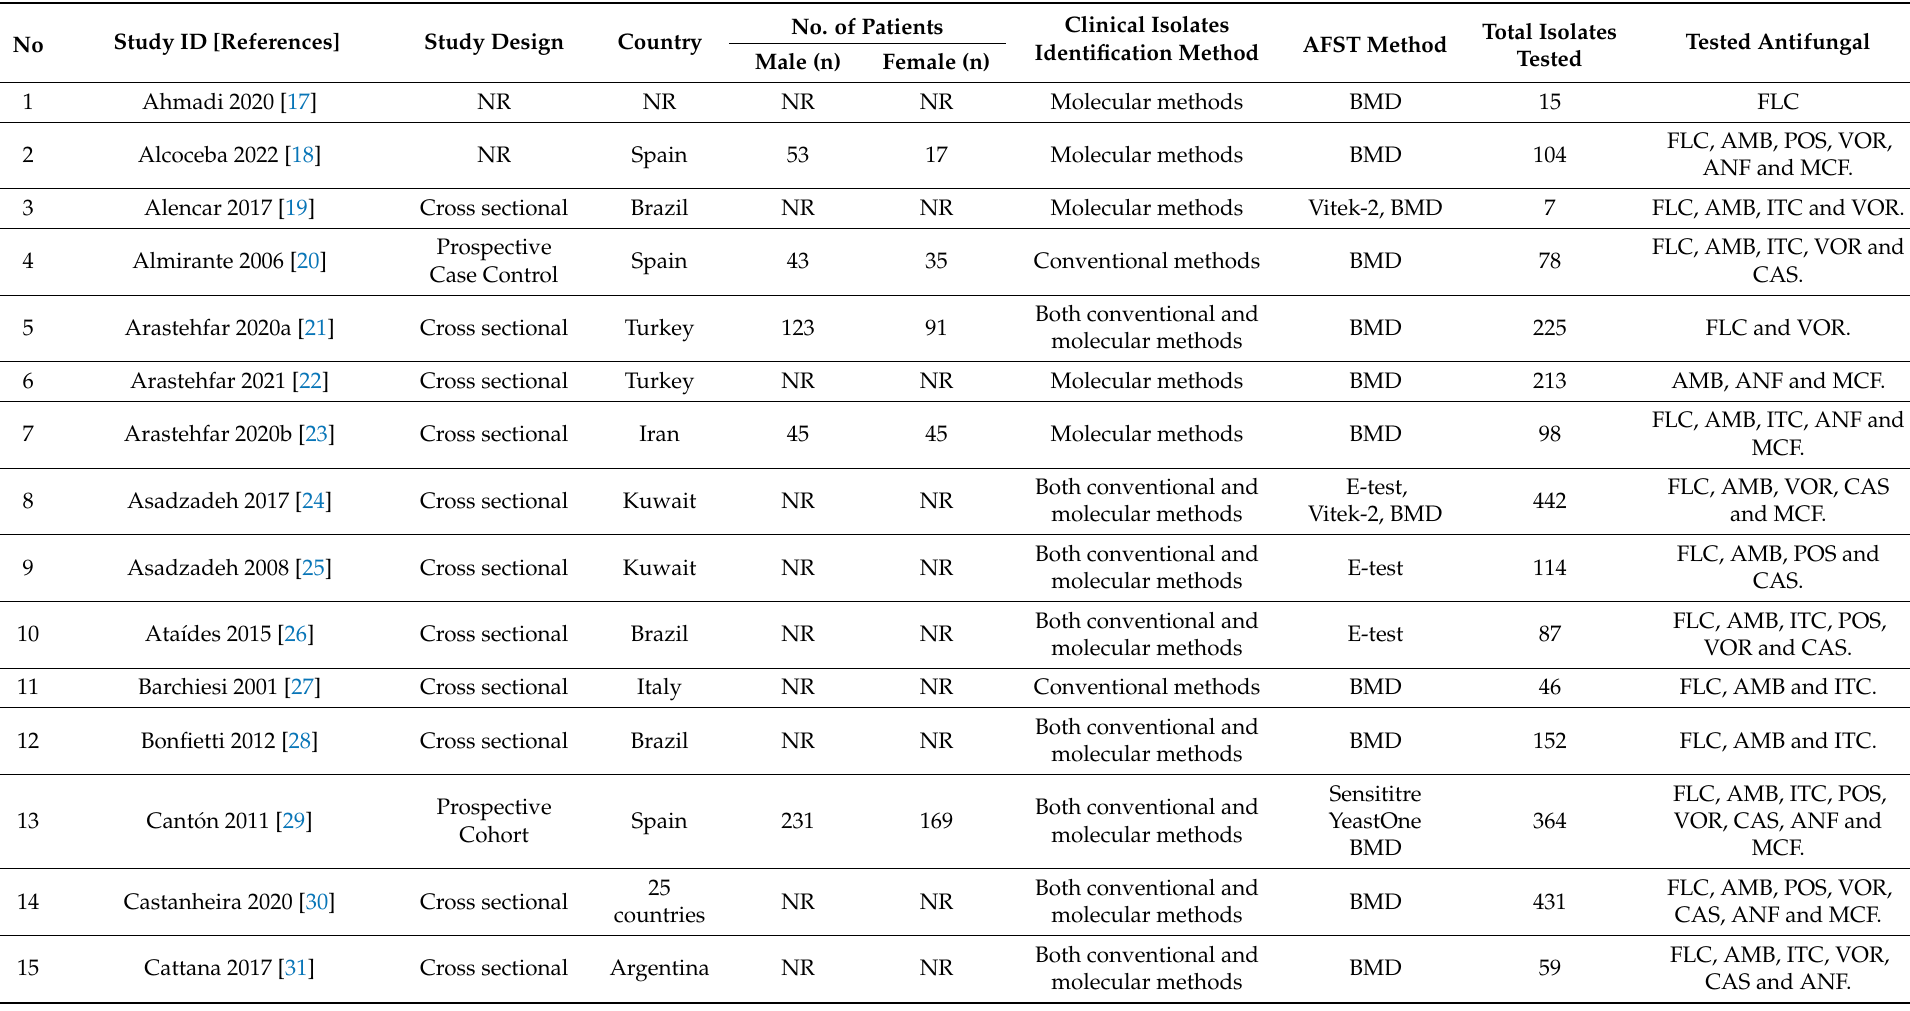
Table 1. Detailed characteristics of 79 studies included in